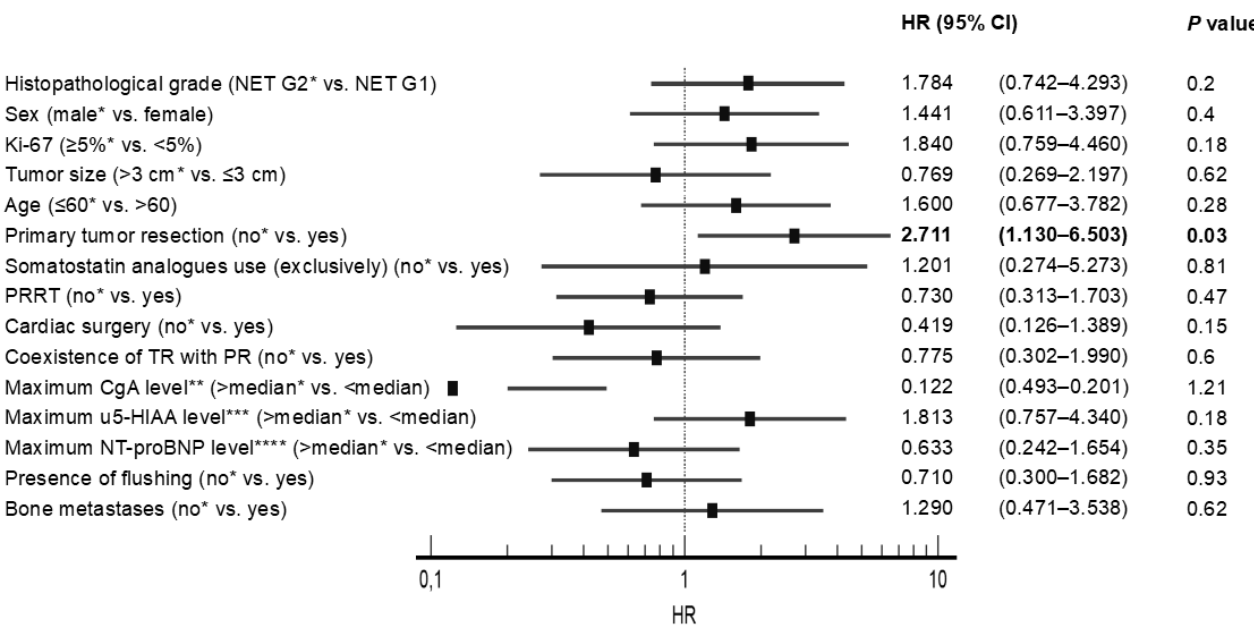
Figure 3. Univariate analysis with hazard ratios (HR) in patients with carcinoid heart disease. * Ref- erence; ** Median maximum chromogranin A (CgA) level – 17.1 ULN; *** Median maximum 5-hy-